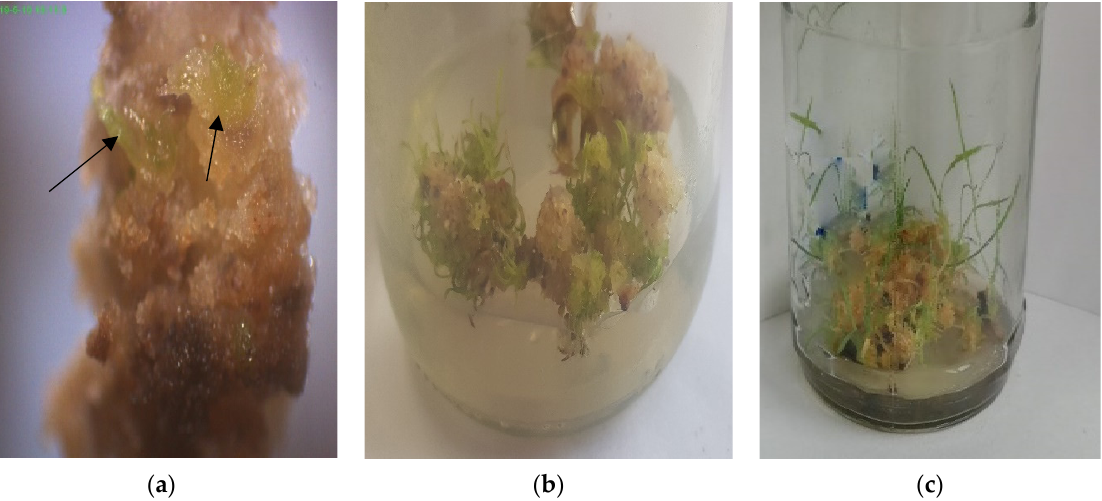
Figure 12. ( a ) Stereomicrograph showing shoot induction (arrows) from callus culture in NSG-59 on MS + 2 mg/L Kinetin (20×), ( b ) shoot induction in callus of NSG-59 on MS + 2 mg/L Kinetin after 10 days, and ( c ) shoot induction in callus of CP-77-400 on MS + 2 mg/L Kinetin after 20 days of inoculation (2×).